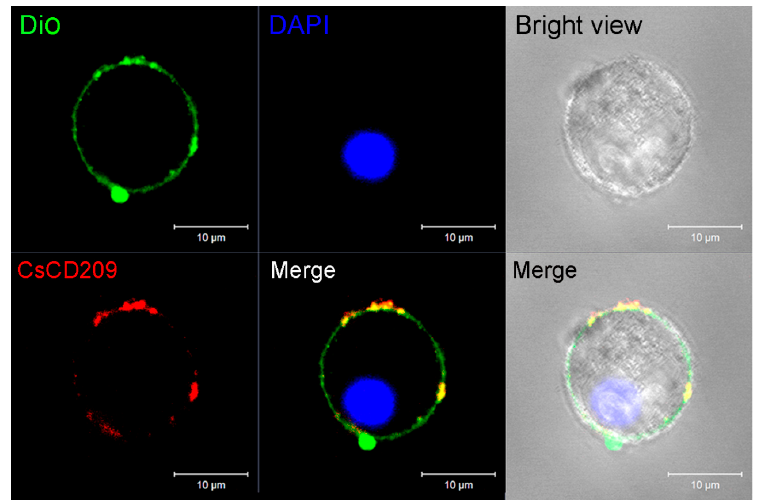
Figure 7. Confocal microscopic analysis of CsCD209 distribution in leukocytes from head kidney. The distribution of CsCD209 was indicated by Alexa Fluor 594 (red color)-labeled goat anti-mouse IgG, the cell membrane was stained by DiO (green color), and the nucleus was stained with 4 ′ -6-diamidino-2-phenylindole (DAPI, blue color). Bar: 5 μ m.